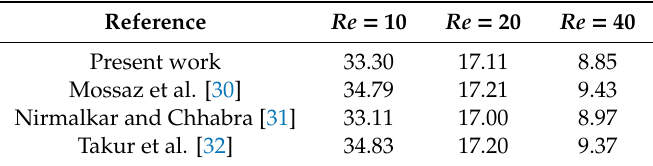
Table 1. Drag variation for three Reynolds number at Bingham number 10 in the current study compared to the previous works.